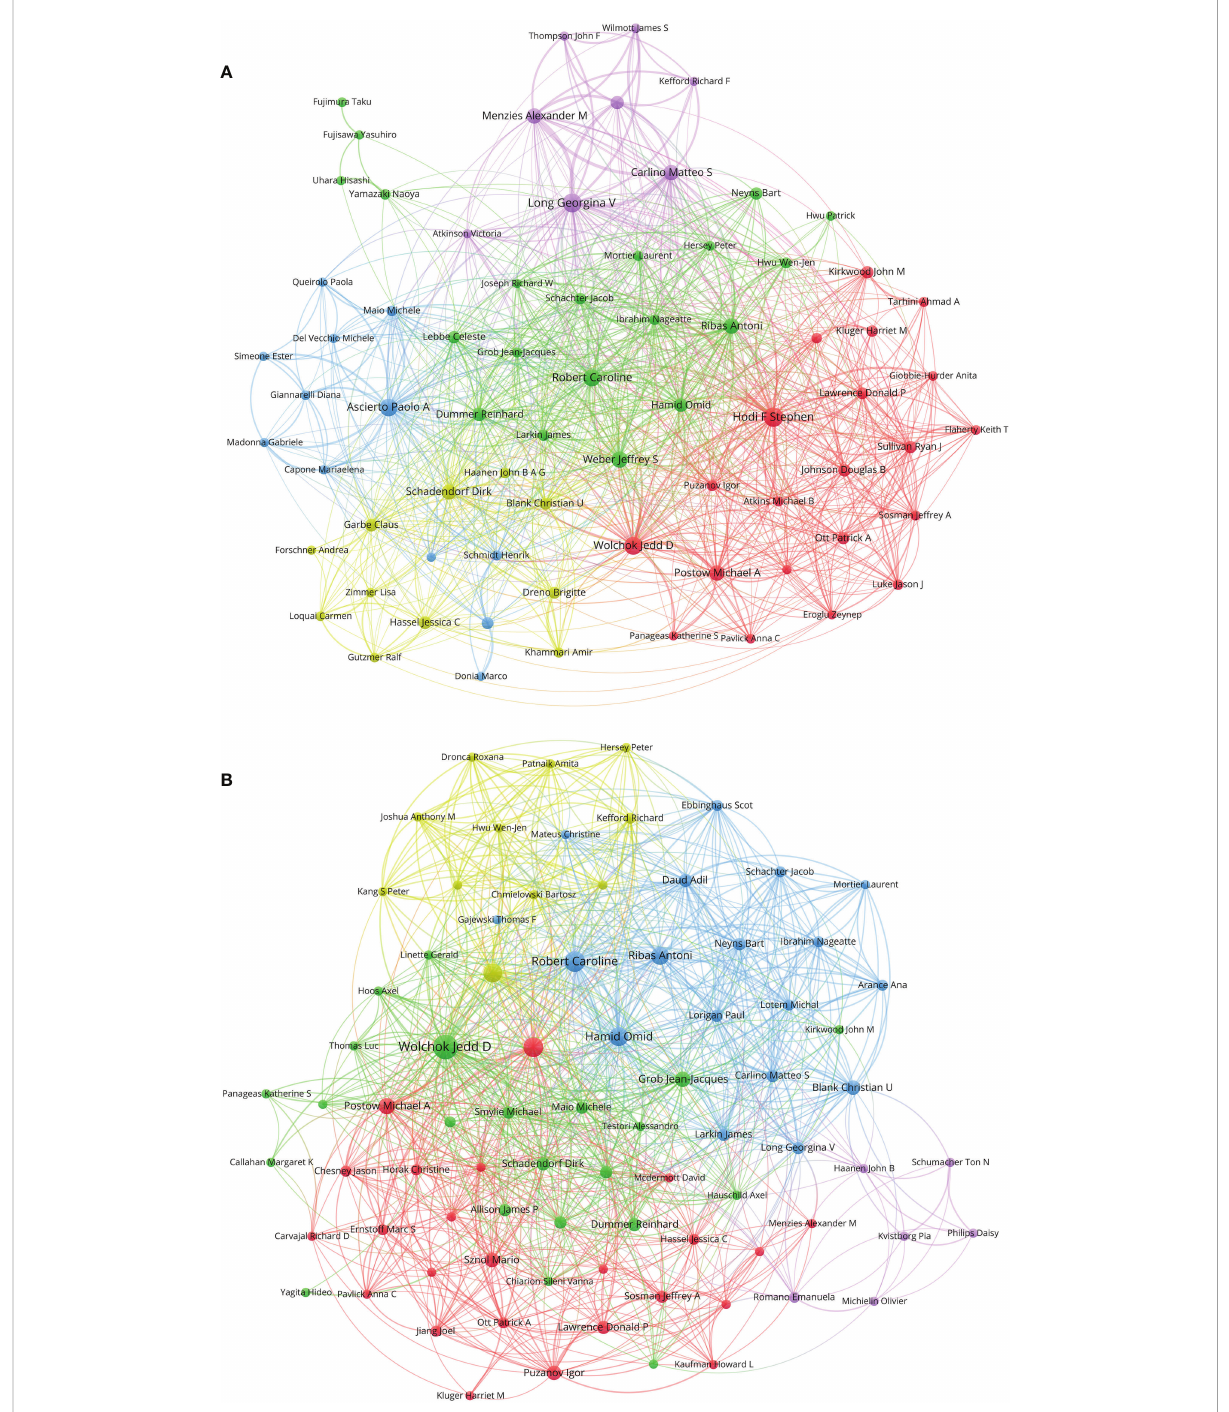
FIGURE 6 (A) Network visualization of authors with at least 15 papers related to melanoma immunotherapy. (B) Network visualization of authors with at least three top-papers related to melanoma immunotherapy. The circle size represents the number of papers. The breadth of the curves represents the connection strength. The authors in the same color have stronger collaboration with each